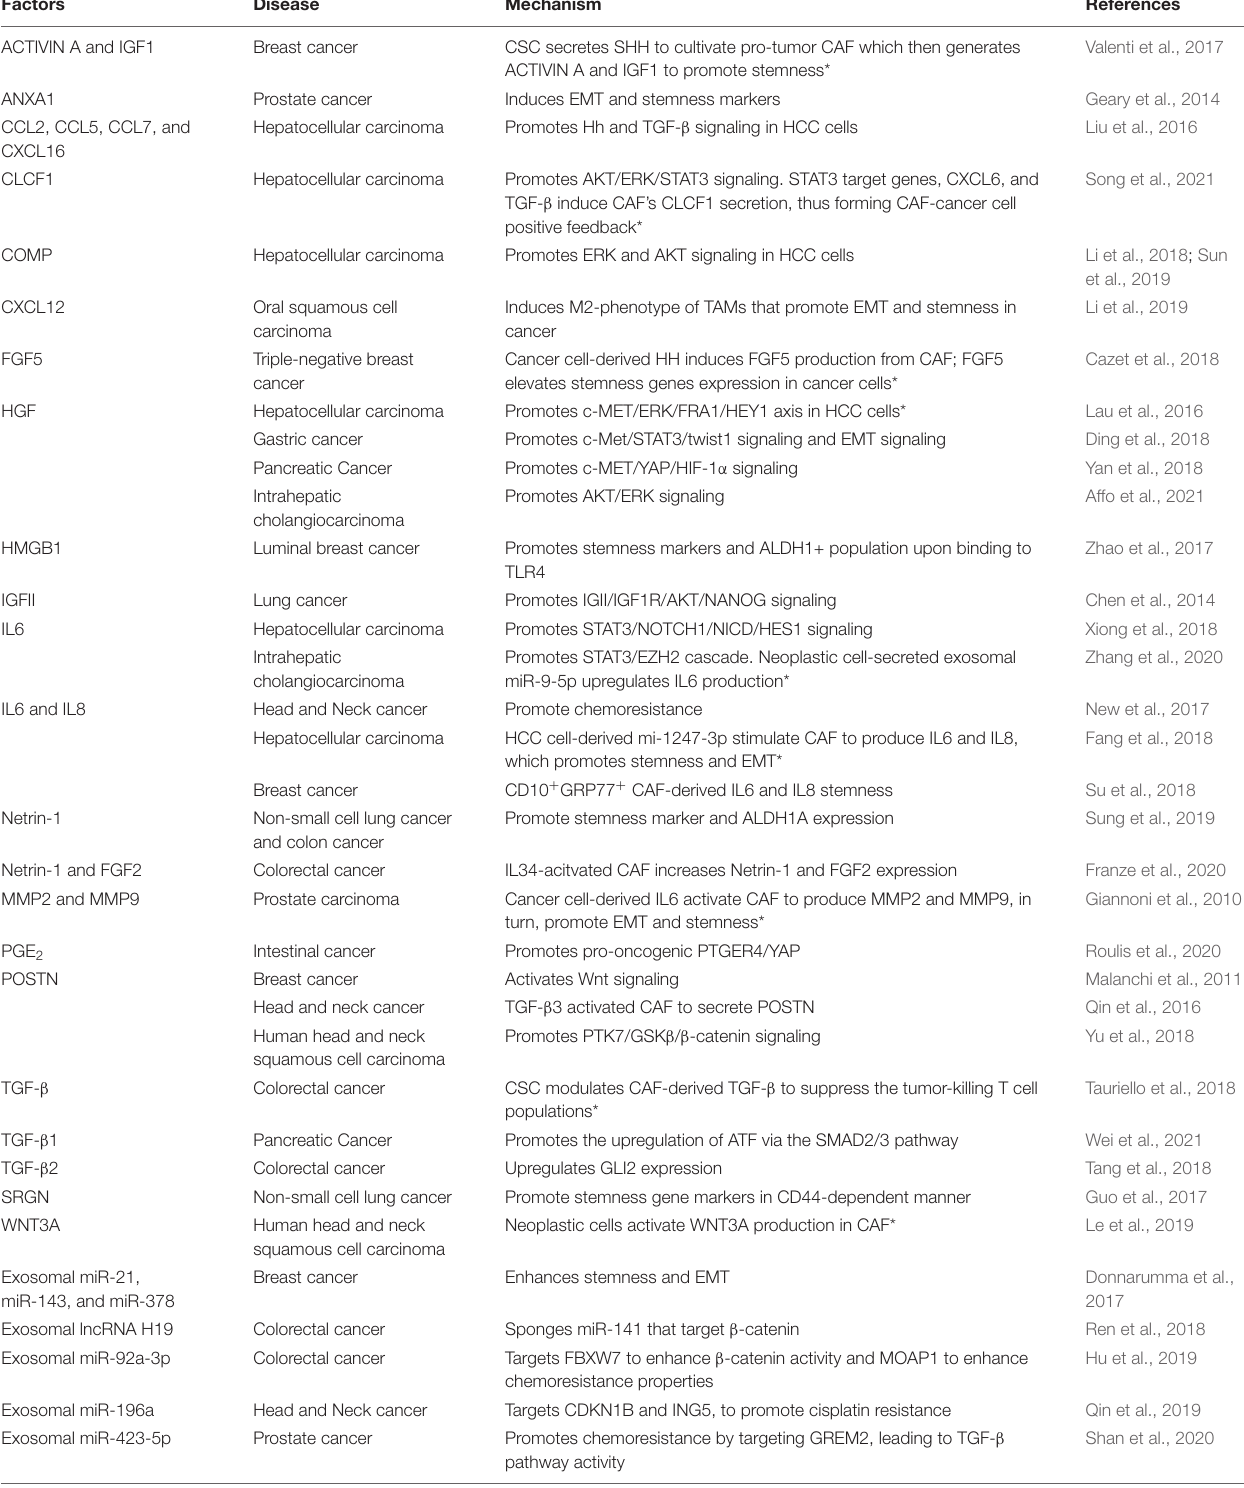
TABLE 1 | Cancer-associated fibroblast (CAF)-derived factors on cancer